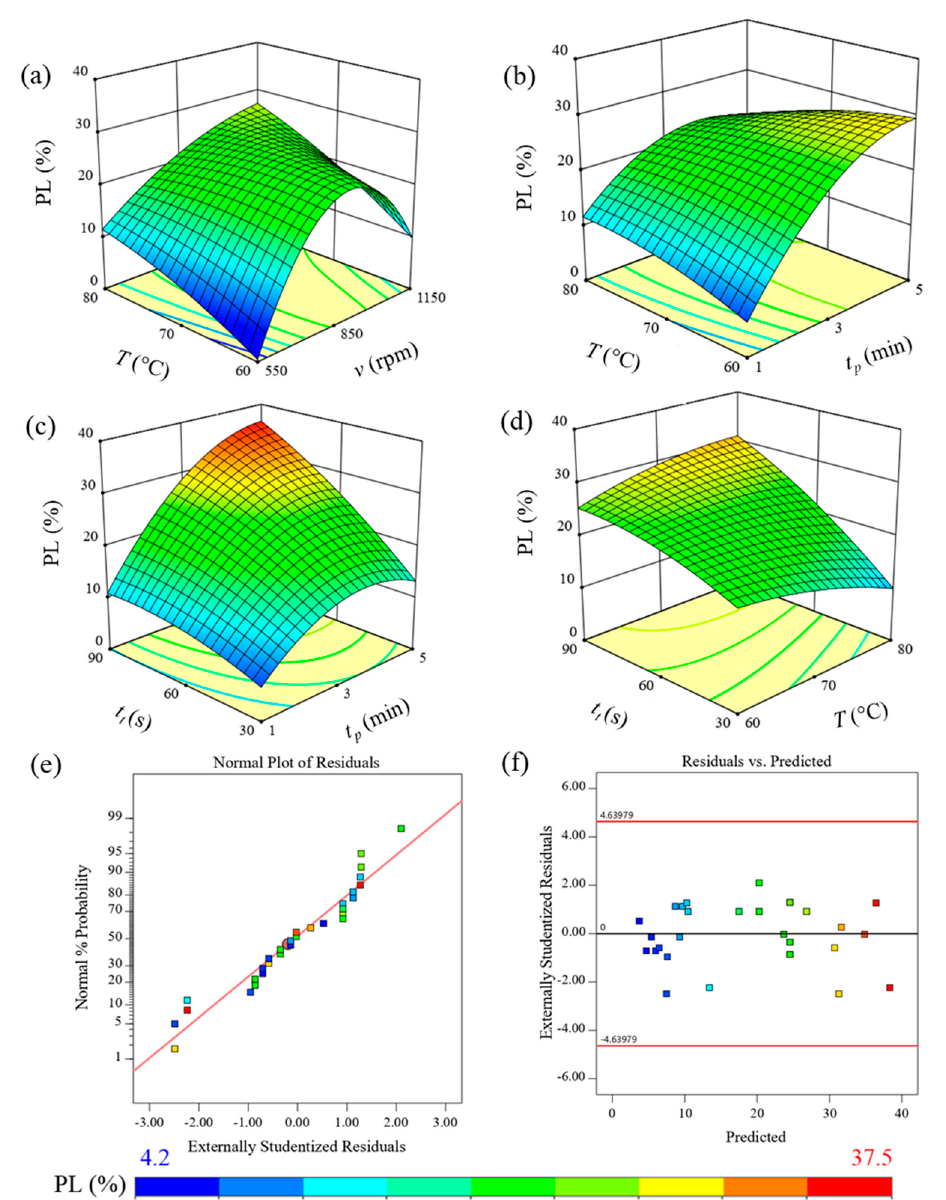
Figure 3. ( a – d ) Surface plots indicating the effect of the rotational speed of the brushes v (rpm), peeling time t p (min), thawing temperature T (°C), and incubation time t t (s) on the peel loss PL (%) of cassava tubers, while keeping the other variables constant. ( e ) Normal probability plot of the residuals of PL. ( f ) Plot of residuals versus predicted values of PL.